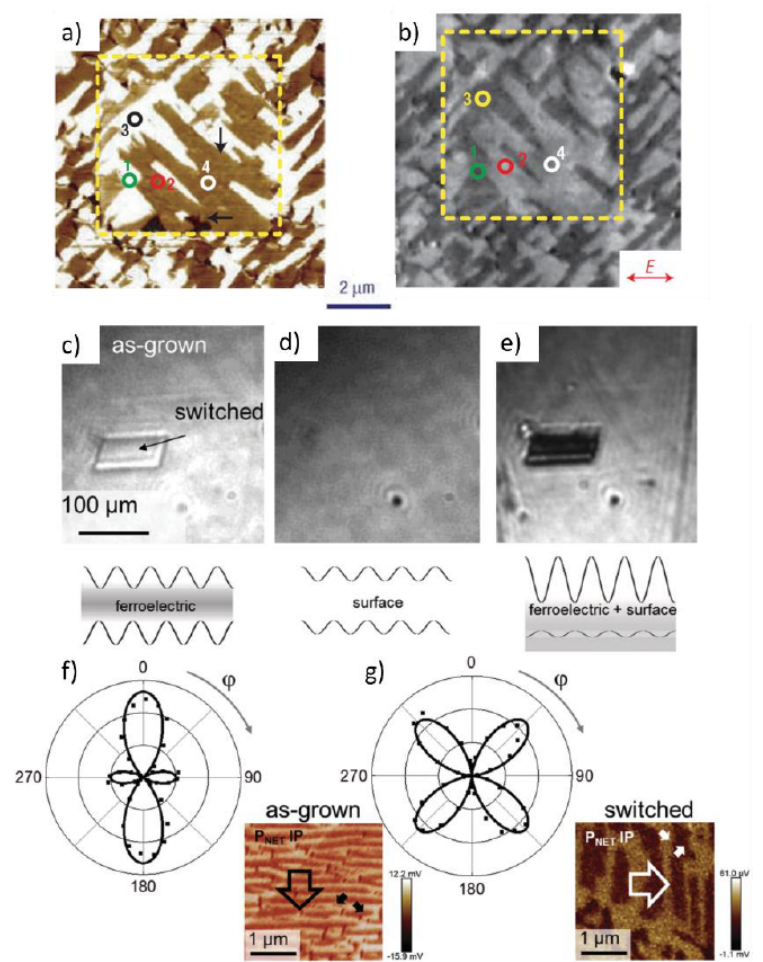
Figure 12. Switching events in BFO thin films. ( a , b ) Coupled switching of ferroelectric, ( a ) and antiferromagnetic ( b ) orders in BFO thin films. The one-to-one domain correlation persists after local voltage application (within the area delimited by the yellow dashed line). Reprinted by permission from [108], Copyright Macmillan Publishers Ltd.: Nature Materials, 2006. ( c – e ) SHG images of an SPM tip-poled 100 × 50 µ m 2 field in BFO on DSO (110), using surface SHG interference to selectively